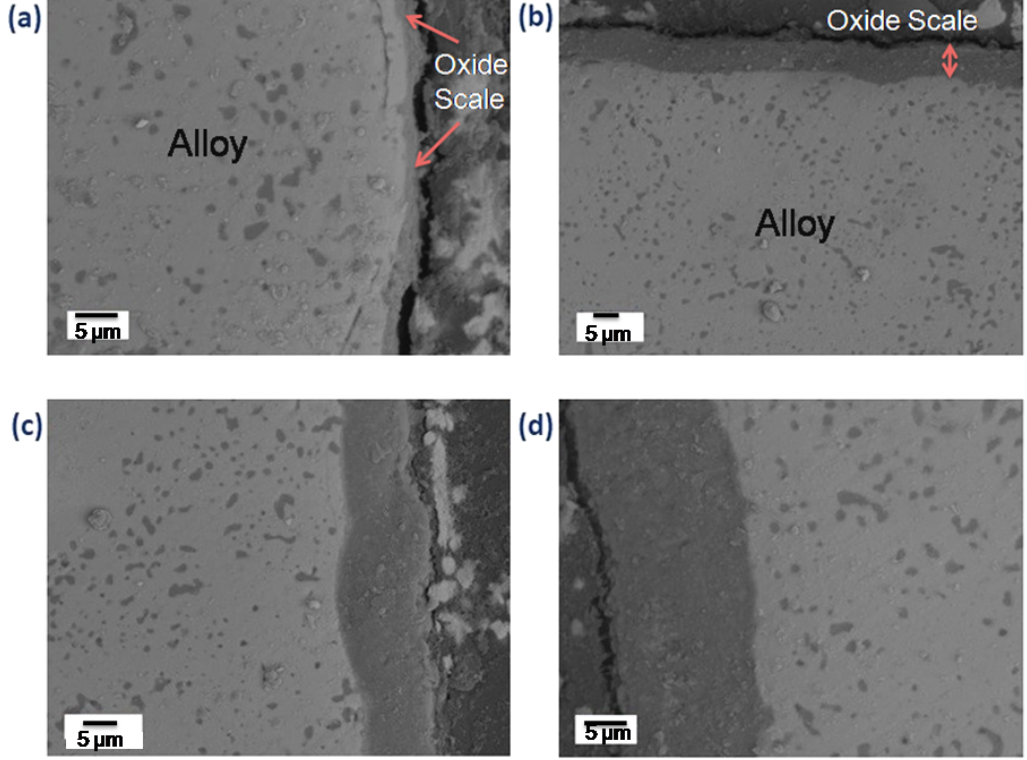
Figure 3: Cross-sectional BSE images of the Mo-Ti-Si composite oxidized at 1100 ∘ C in air for (a) 1 h, (b) 25 h, (c) 50 h and (d) 100 h.